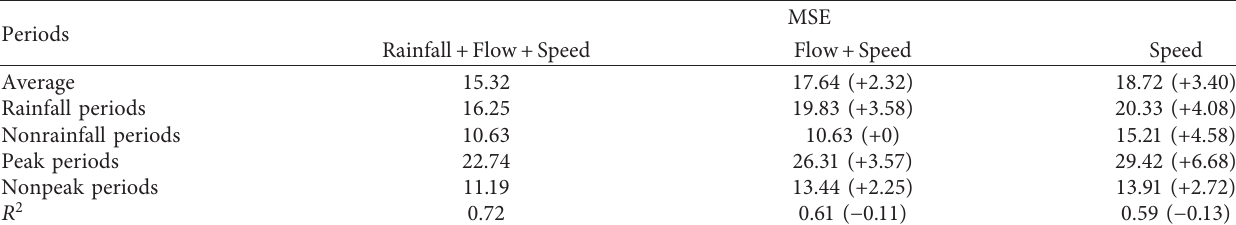
Table 2: Performance comparison of three input data combinations and periods.